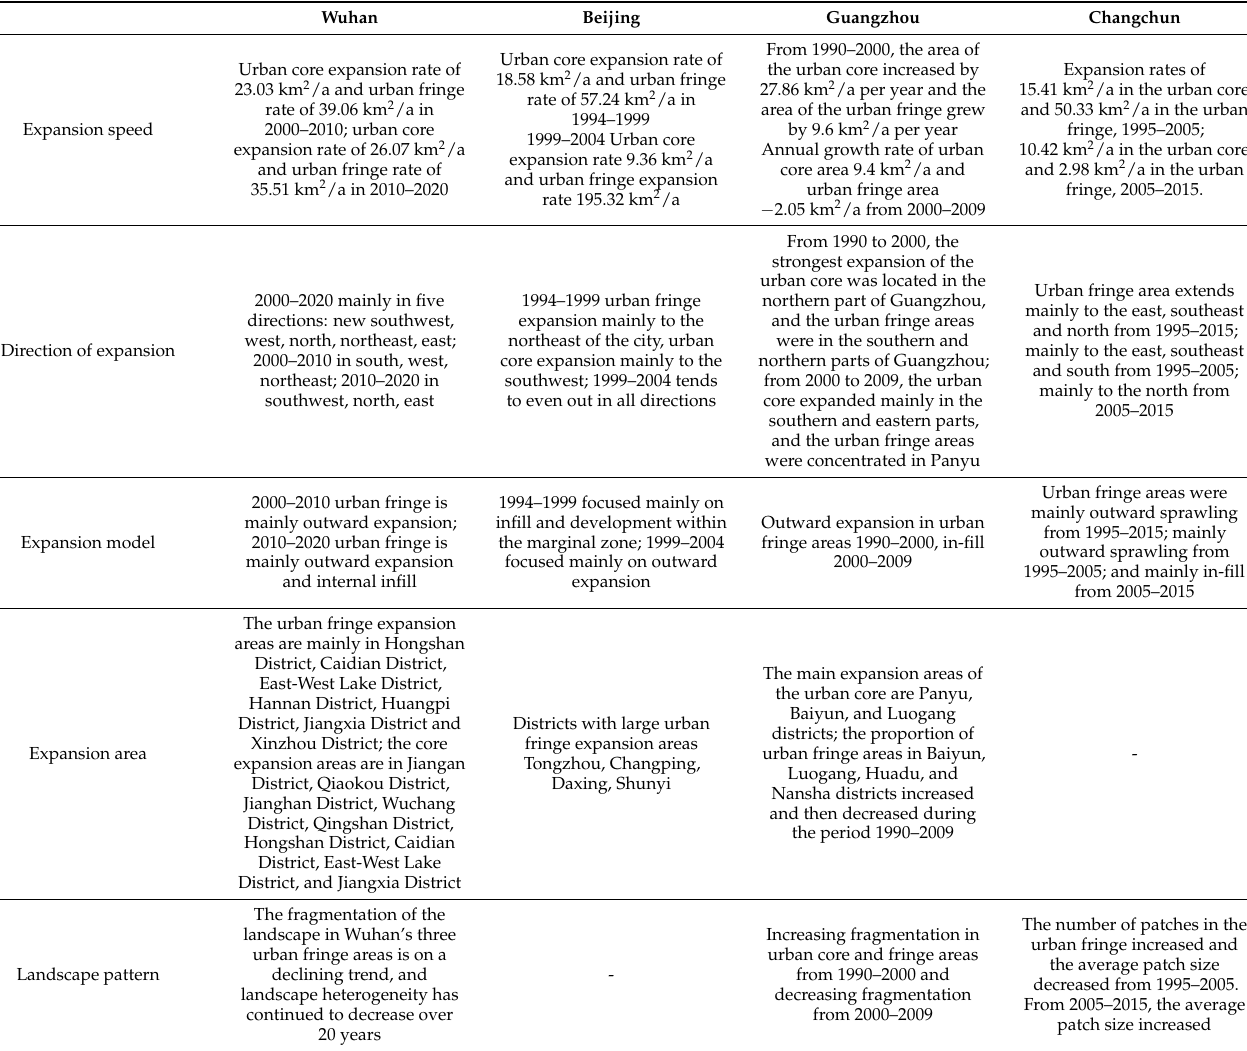
Table 16. Comparison of Urban Expansion Characteristics of Wuhan, Beijing, Guangzhou, and